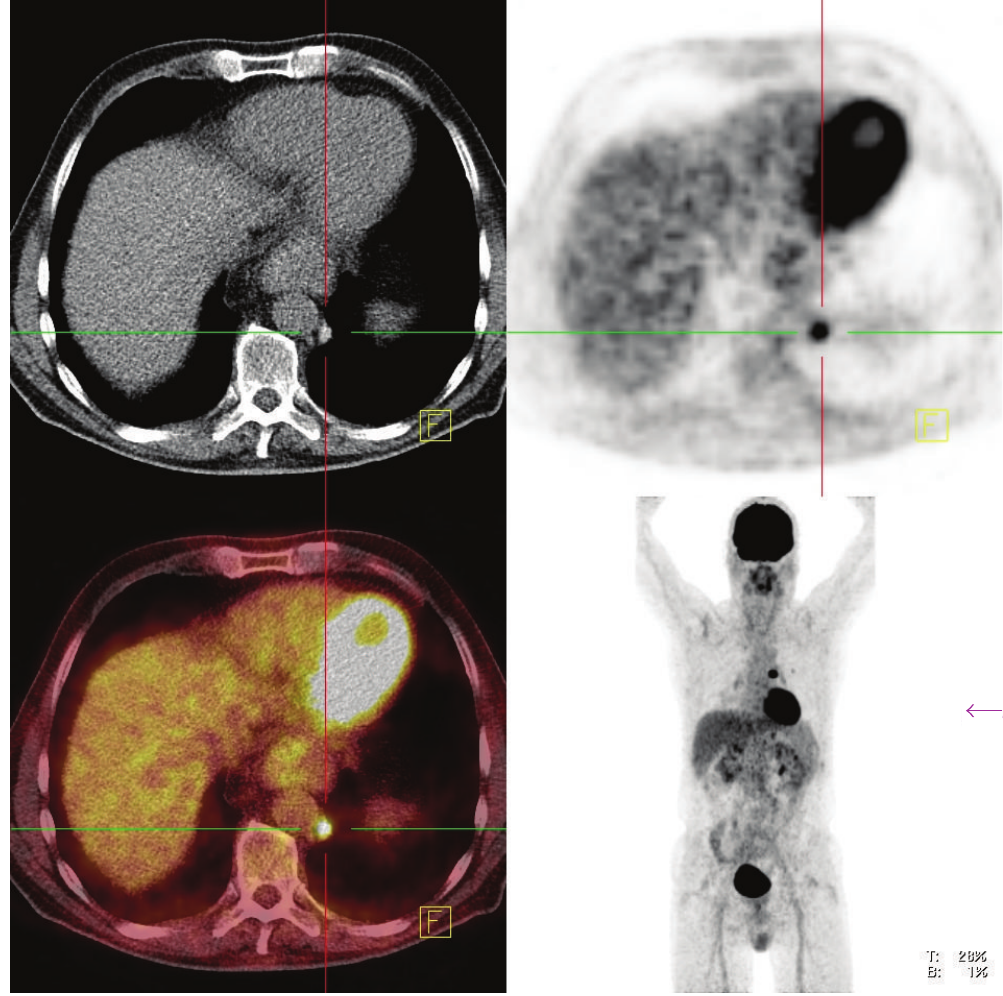
Figure 2: FDG-avid paraaortic nodal structure.